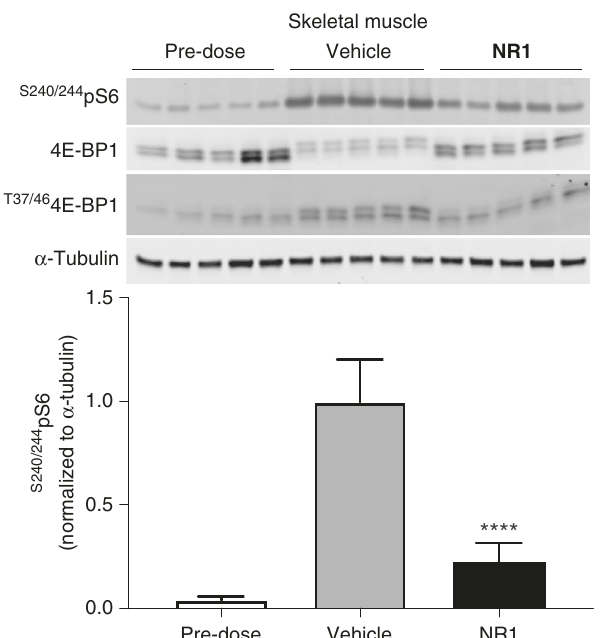
Fig. 6 NR1 inhibits feeding-induced mTORC1 activation in skeletal muscle. Mice were starved for 16 h pre-dose to achieve a basal level of mTORC1 activity, then dosed with NR1 (30 mg kg − 1 IP) or vehicle and allowed to re- feed ad libitum. After 2 h, gastrocnemius muscle was collected, and S240/ 244 pS6 levels were measured by Western blot and quanti fi ed. The results are shown as mean ± SEM ( n = 5 per group). One way ANOVA for NR1 with respect to vehicle are as follows: F (2, 12) = 73.8, p <